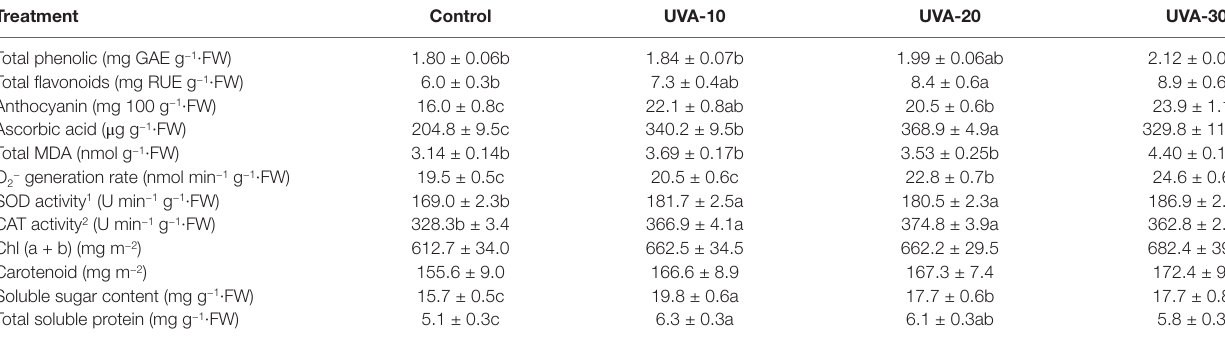
Data represent mean ± SE (n = 16). Means followed by different letters within one row differ significantly (P < 0.05) as established by the least significant difference test. 1 50% of the photoreduction of nitroblue tetrazolium (NBT) is used as an enzyme activity unit. 2 1 nmol of H 2 O 2 degradation per minute is defined as an enzyme activity unit.